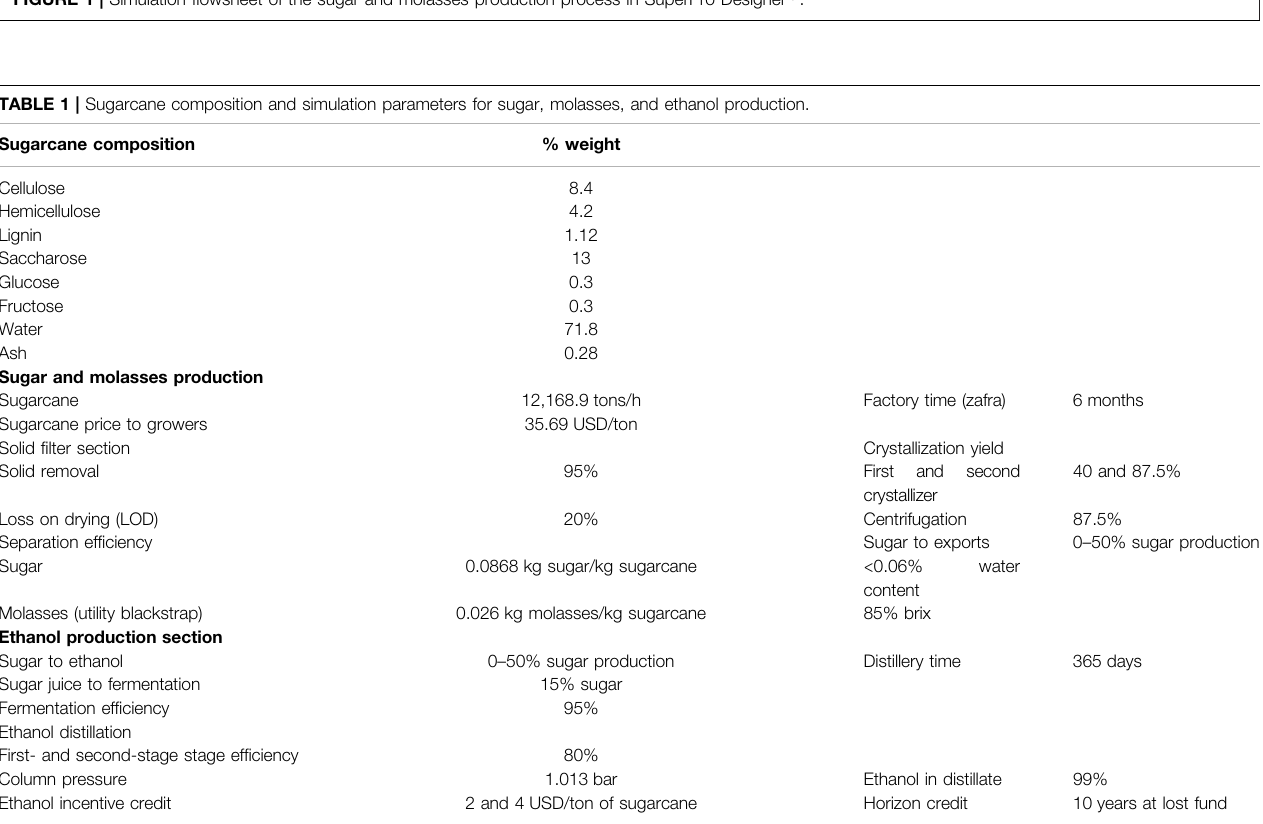
( Table 1 ). Sugarcane main processing units to ethanol comprise the additional steps: sugar juice conditioning, fermentation,